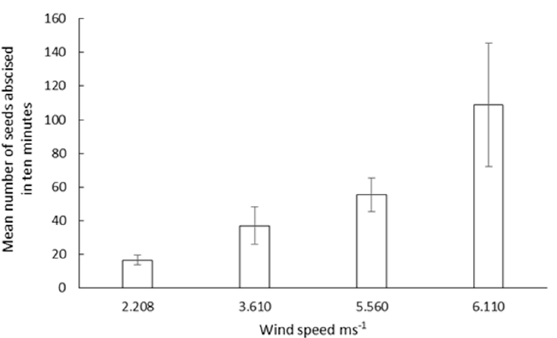
Figure 6. The mean ( ± 1 SE) rates of seed abscission at different wind speeds. The rates of seed abscission increased with wind speed. However, the data show the optimal wind speed to maximize height attained by the seed; hence, long-distance dispersal is 3.61 m/s.